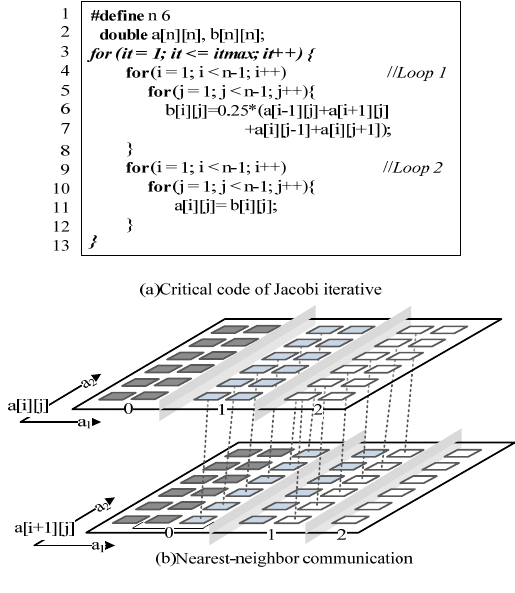
Figure 11. Jacobi